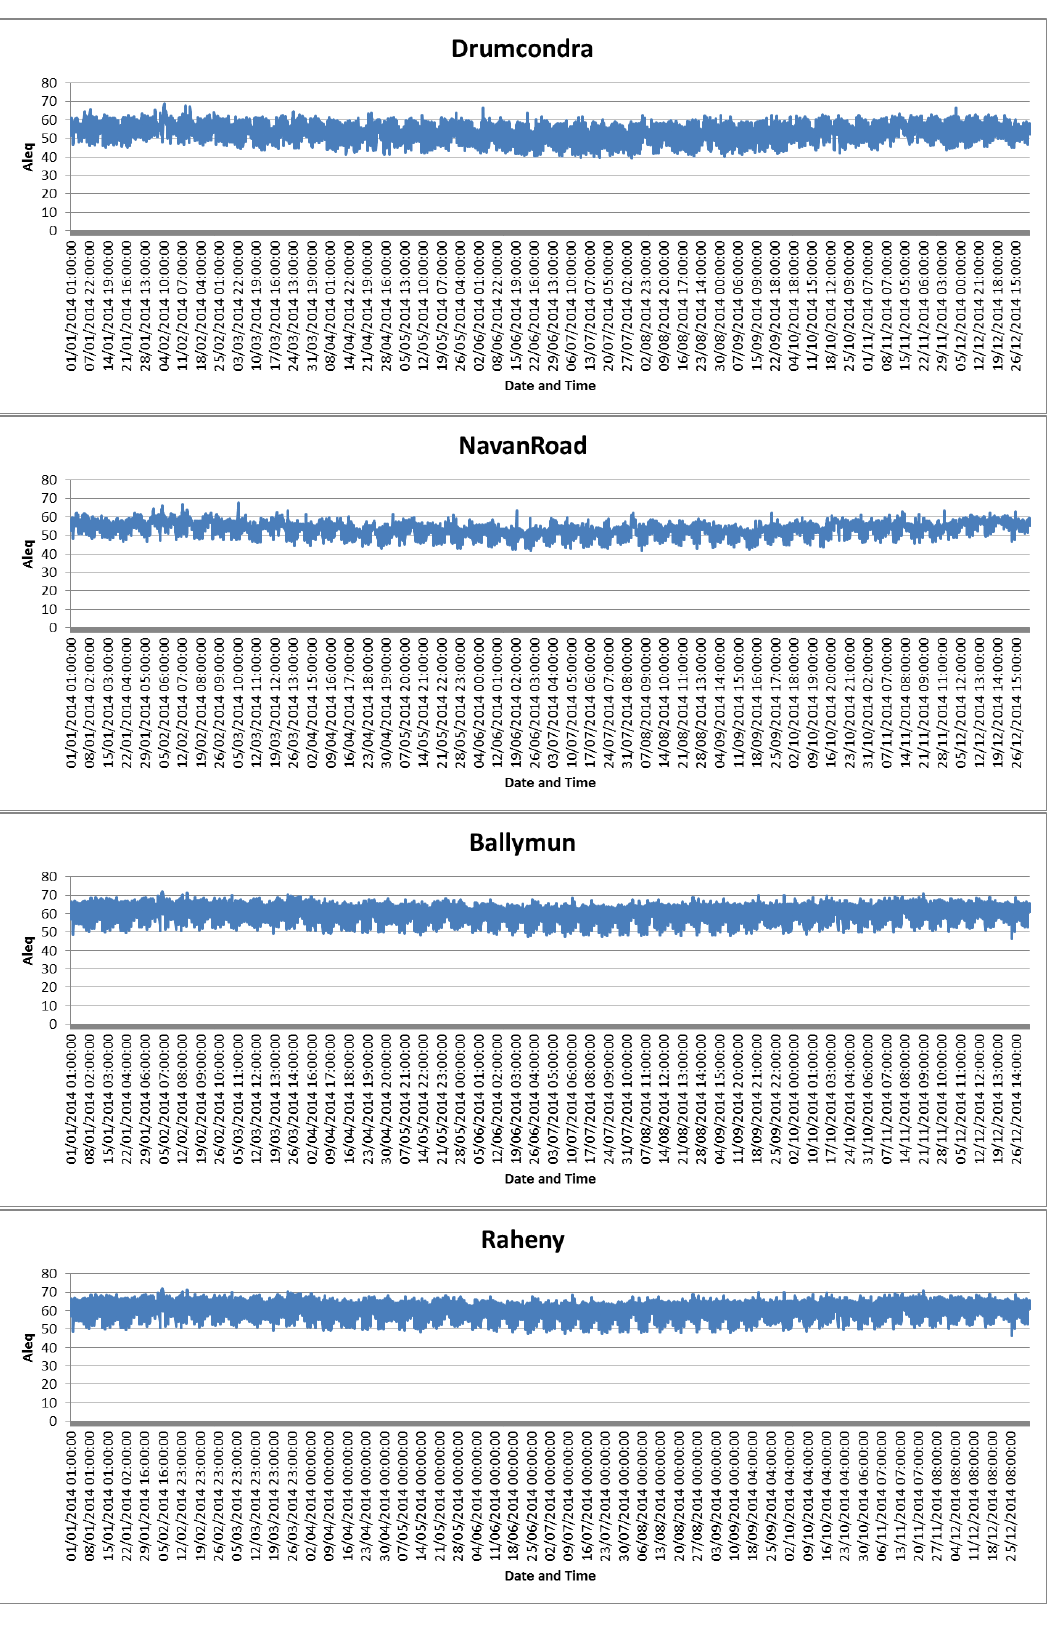
Supplementary Figure 3: AL eq at hourly resolution